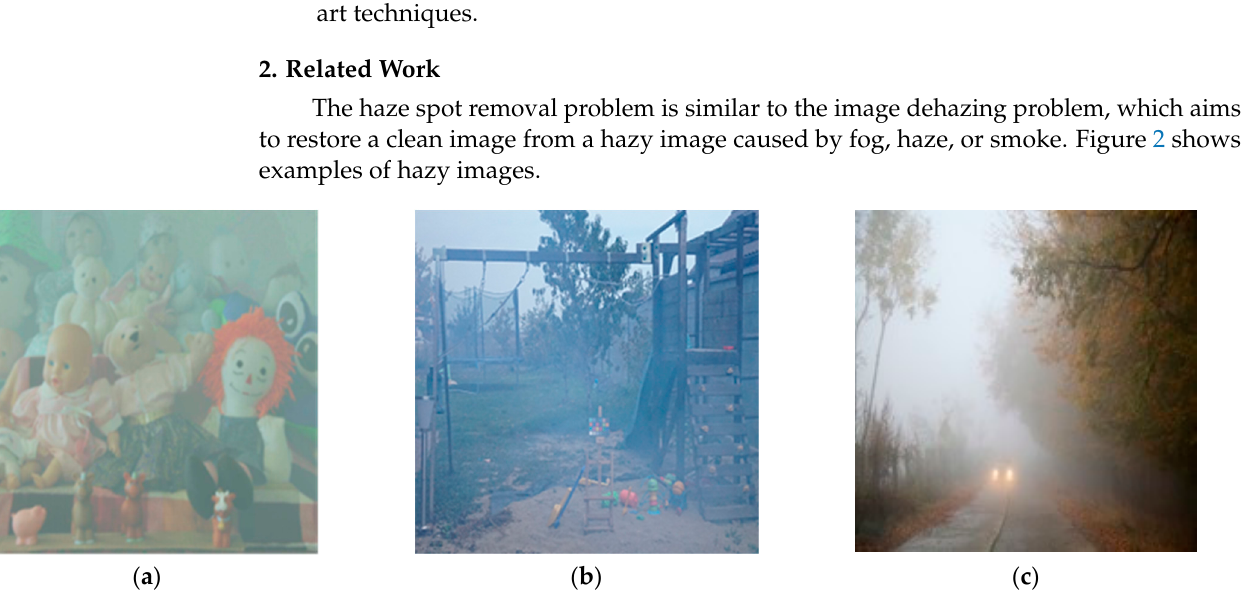
Figure 2. Examples of images with haze: ( a ) simulated indoor haze image from I ‐ Haze dataset [39]; ( b ) simulated outdoor haze image from O ‐ Haze dataset [40]; ( c ) real haze image. The formation of haze in images can be described by an atmospheric scattering model 𝐼(cid:4666)𝑥(cid:4667) (cid:3404) 𝐽(cid:4666)𝑥(cid:4667)𝑡(cid:4666)𝑥(cid:4667) (cid:3397) 𝐴(cid:3435)1 (cid:3398) 𝑡(cid:4666)𝑥(cid:4667)(cid:3439) (1) where 𝐼(cid:4666)𝑥(cid:4667) and 𝐽(cid:4666)𝑥(cid:4667) represent the hazy and clean images, respectively. 𝑡(cid:4666)𝑥(cid:4667) is the transmission map and 𝐴 is the global atmospheric light. When atmospheric light is ho ‐ mogeneous, 𝑡(cid:4666)𝑥(cid:4667) (cid:3404) 𝑒 (cid:2879)(cid:3081)(cid:3031)(cid:4666)(cid:3051)(cid:4667) where 𝛽 refers to the attenuation coefficient, and 𝑑(cid:4666)𝑥(cid:4667) re ‐ fers to the depth information of the scene. Recently, many studies have been conducted to address the image ‐ dehazing prob ‐ lem. These methods may be generally divided into two approaches, including intermedi ‐ ate ‐ based methods and end ‐ to ‐ end based methods. Intermediate ‐ based methods first estimate a transmission map 𝑡(cid:4666)𝑥(cid:4667) and an atmos ‐ pheric light 𝐴 , and then restore a clean image by applying the atmospheric scattering model. Intermediate ‐ based methods can be classified as prior ‐ based methods [23,24] and learning ‐ based methods [25,26]. The prior ‐ based method estimates a transmission map by hand ‐ crafted priors that are designed to distinguish between hazy and clean images, such as the dark channel prior [23] and color attenuation prior [24]. The learning ‐ based meth ‐ ods estimate the intermediate parameters by learning a transformation from the haze im ‐ age to the transmission map 𝑡(cid:4666)𝑥(cid:4667) and atmospheric light 𝐴 using convolutional neural networks (CNNs), such as DehazeNet [25] and multi ‐ scale CNN [26]. The intermediate ‐ based method is not applicable to our haze spot ‐ removing problem because it is impossi ‐ ble to acquire the transmission map 𝑡(cid:4666)𝑥(cid:4667) and atmospheric light 𝐴 from the haze spot image (Figure 1c). The end ‐ to ‐ end based method, which is the most recent trend for the image dehazing problem, learns a pixel ‐ to ‐ pixel mapping between hazy and clean images. Thus, this method can directly transform a hazy image into a clean image without using the atmos ‐ pheric scattering model. An end ‐ to ‐ end deep ‐ dehaze network was proposed in [30] by embedding a residual network into U ‐ Net, which has a symmetrical structure comprising a contracting encoder, an expanding decoder, and a skip connection between the encoder and decoder that can retrieve the missing spatial information. GridDehazeNet [31] inte ‐ grated an attention mechanism, which encouraged the model to enhance the vital features of the input image into a grid network. The results demonstrated the efficiency of the model. More recently, to make the transformed haze ‐ free image as similar to the clean image as possible, some studies [27–29] have constructed a dehazing model by utilizing GANs. This approach can generate more realistic images and has exhibited promising performance in various types of image ‐ to ‐ image translation tasks, such as image super ‐ resolution [41] and image segmentation [42]. GANs consist of two sub ‐ models, including a generator trained to generate new samples and a discriminator trained to judge whether a sample is real or generated. These two sub ‐ models are trained in a competitive manner, in which the generator learns to generate a sufficiently realistic sample such that the